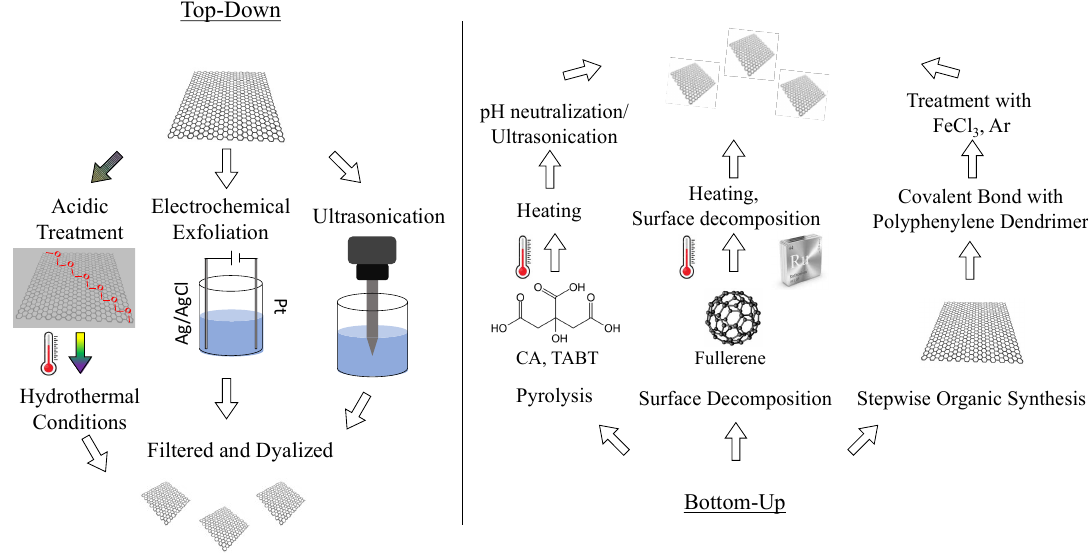
Scheme 1. Representation of the main strategies for the synthesis of GQDs.